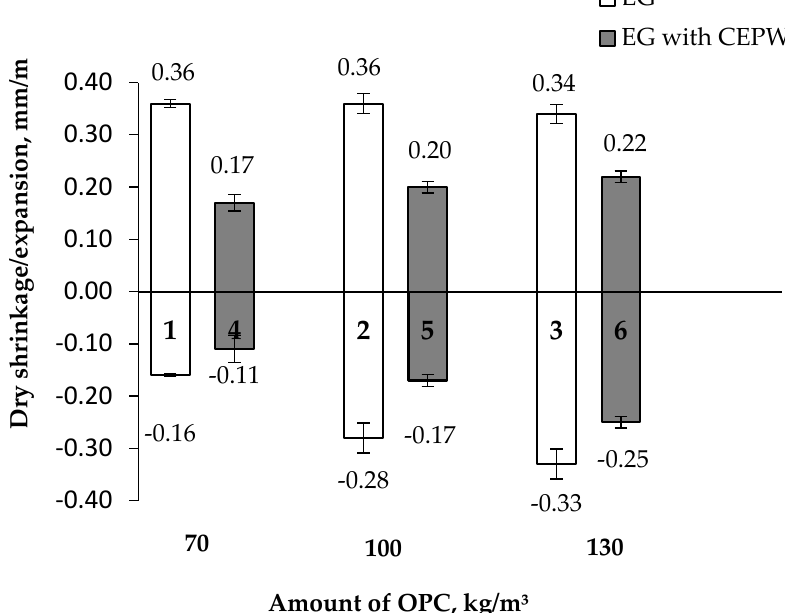
Figure 7. Dependence of LWC shrinkage/expansion on the amount of cement: 1–6—designation of the composite composition (see Table 6).